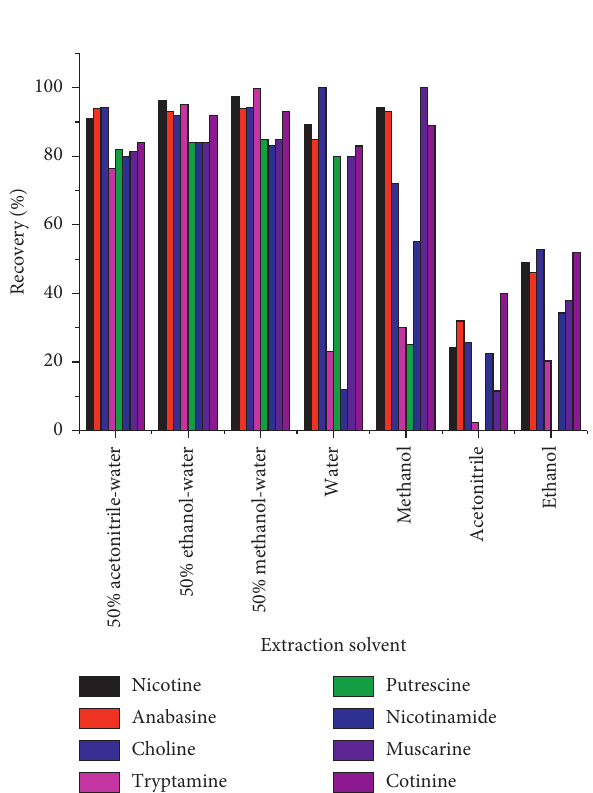
Figure 1: Effect of different solvent on the recoveries of 8 en- dogenous alkaloids.